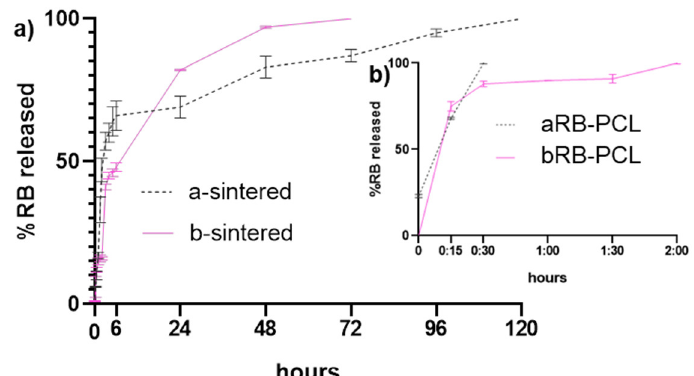
Figure 8. Graphical representation of in vitro release study on: ( a ) aRB-PCL and bRB-PCL; ( b ) aRB- PCL disks (a-sintered) and aRB-PCL disks (b-sintered).